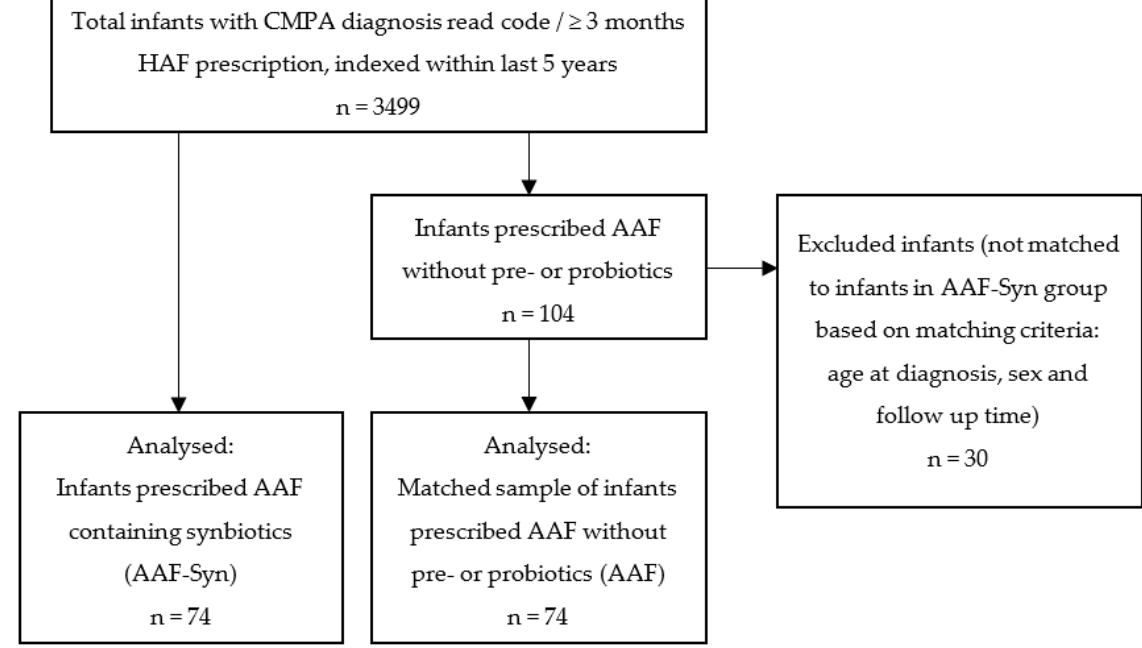
Figure 1. Flowchart summarising the study population selection. Abbreviations: CMPA: cow’s milk protein allergy; HAF: hypoallergenic formulae; AAF: amino acid formula; AAF-Syn: amino acid formula containing synbiotics.